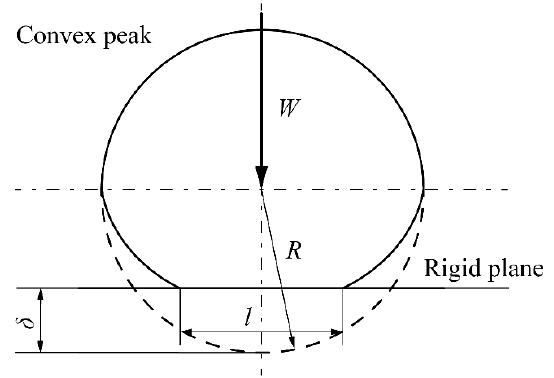
Figure 2. Deformation mechanism of the peak.